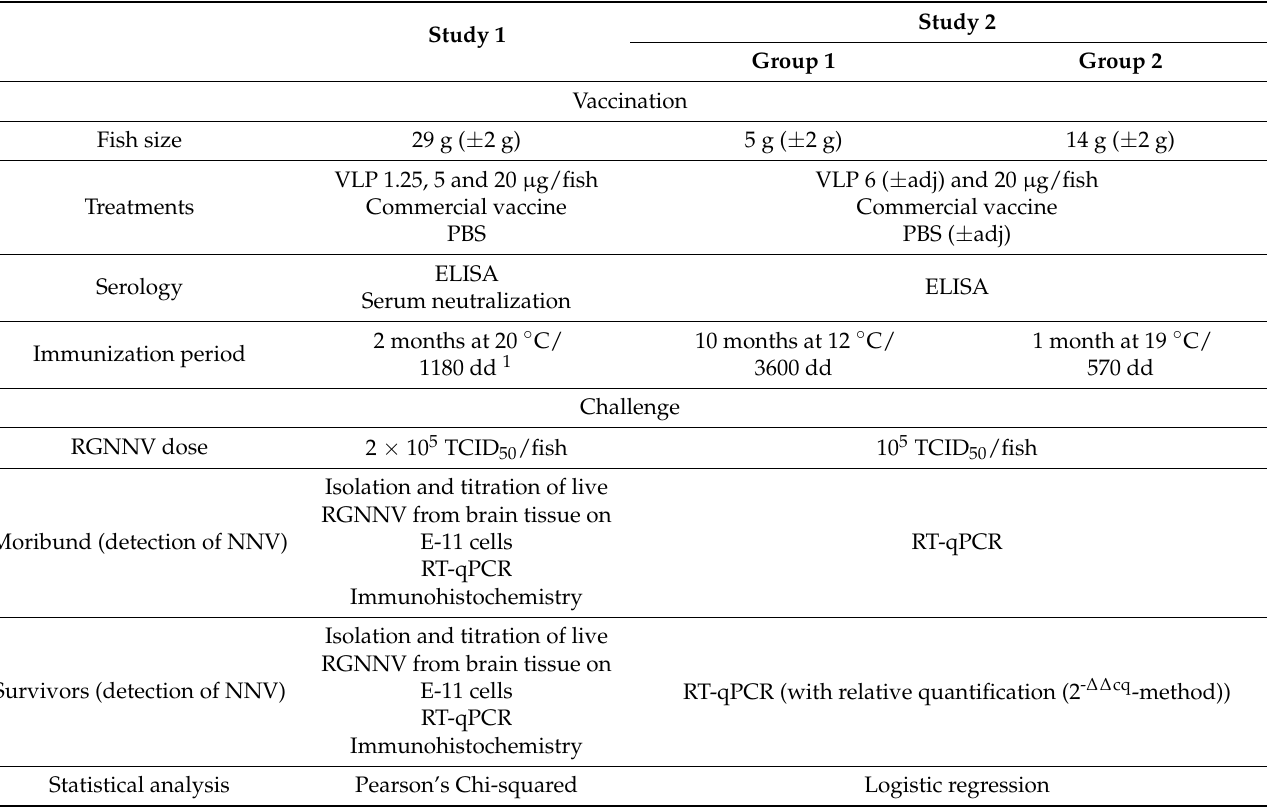
Table 1. Overview of details and analysis in Study 1 and